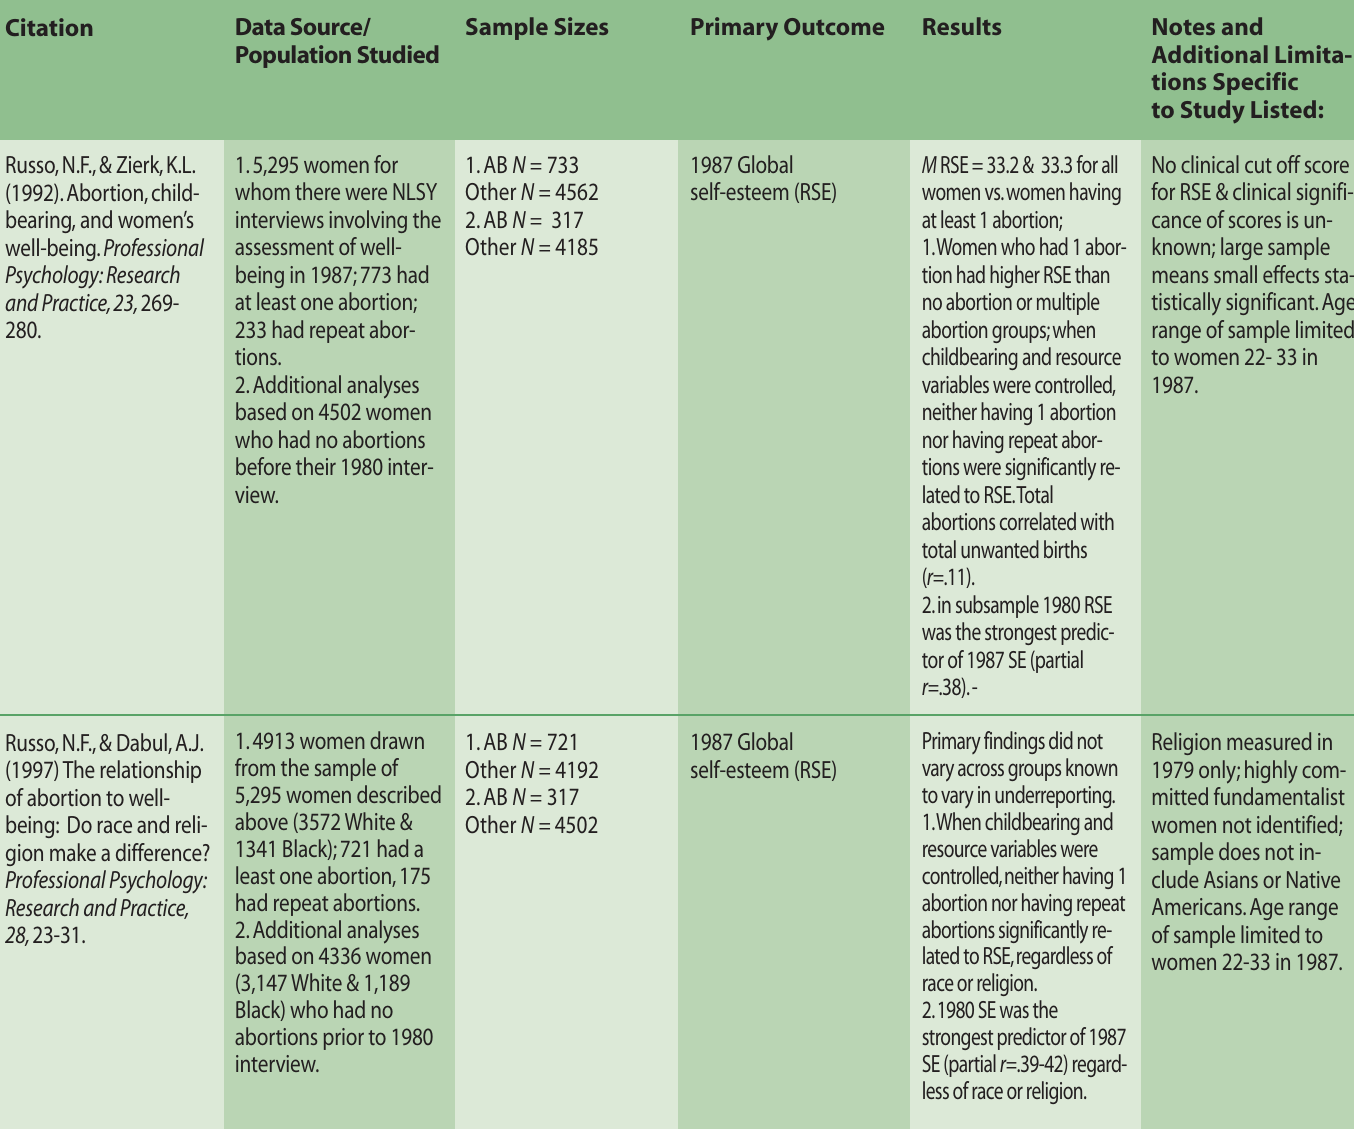
Table 2: Secondary Analyses of Survey Data–Abortion vs.Comparison Groups